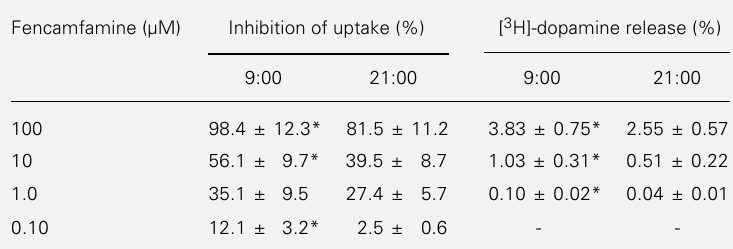
Table 2 - Light-dark phase changes in the inhibition of uptake and the release of [ 3 H]- dopamine in striatal